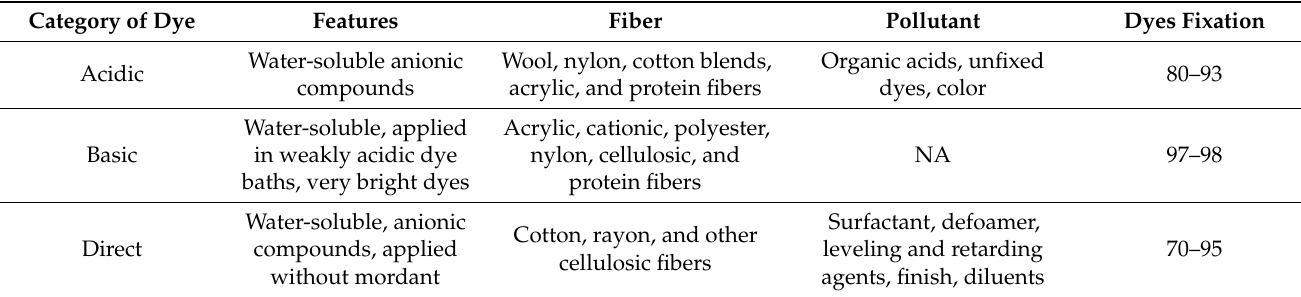
Figure 1. Major classes of dyes. Table 2. Types and characteristics of Azo dyes